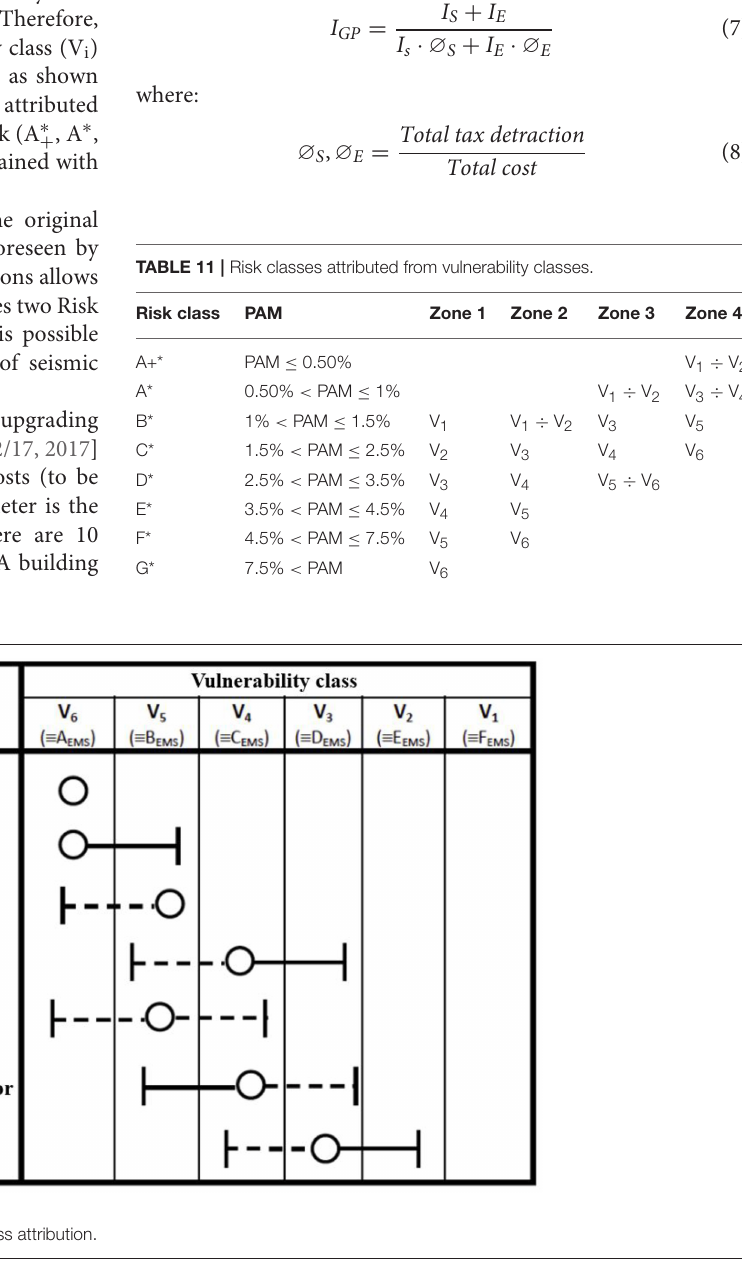
Frontiers in Built Environment |